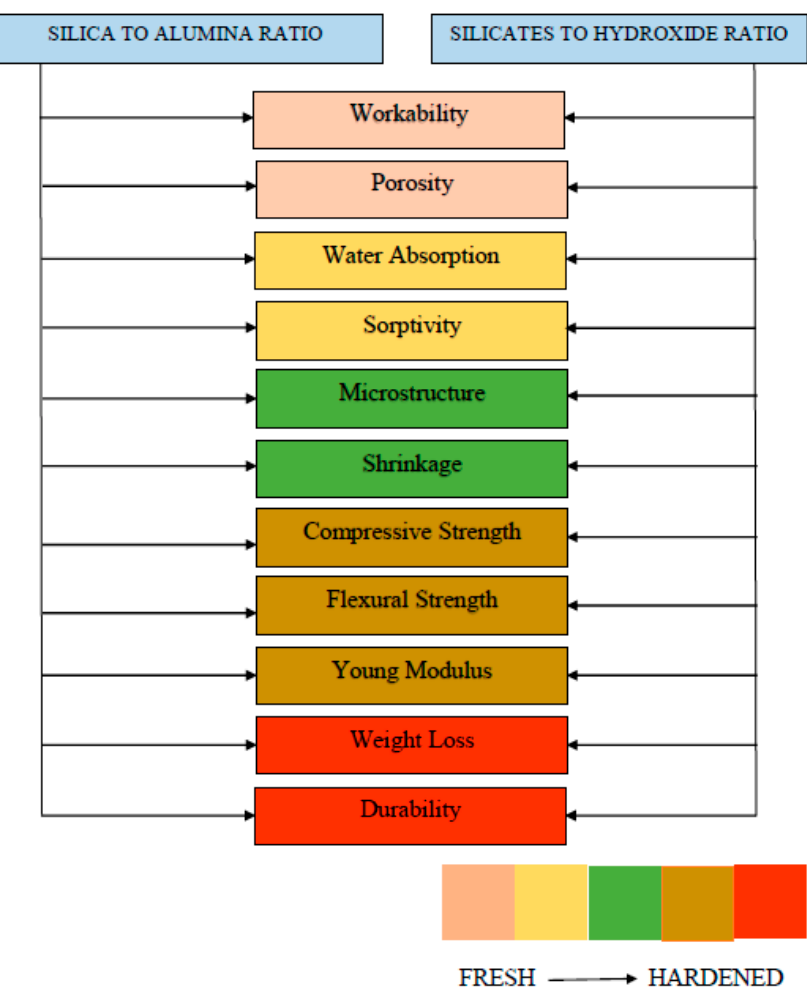
Figure 29. Fresh and hardened properties considered while determining the ratios of GPC.